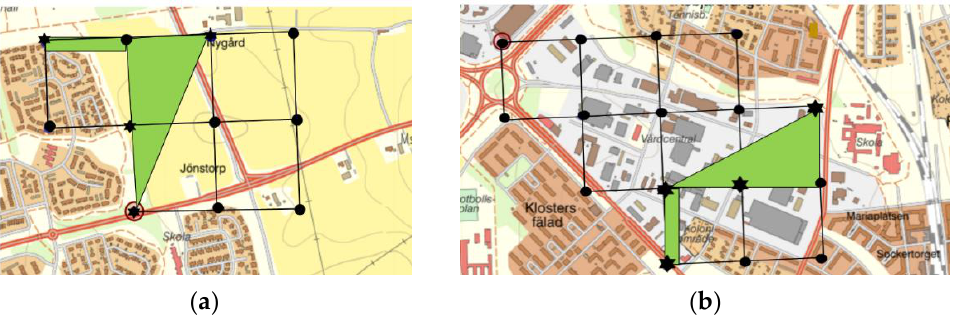
Figure 5. Compensating the loss of green space in two different offset areas on the outskirts of the city ( a ) and in the city center, in Västerbro ( b ). The 250 × 250-squares in ( b ) approximately indicate the area to be developed and the green space is placed in the eastern part of the area.